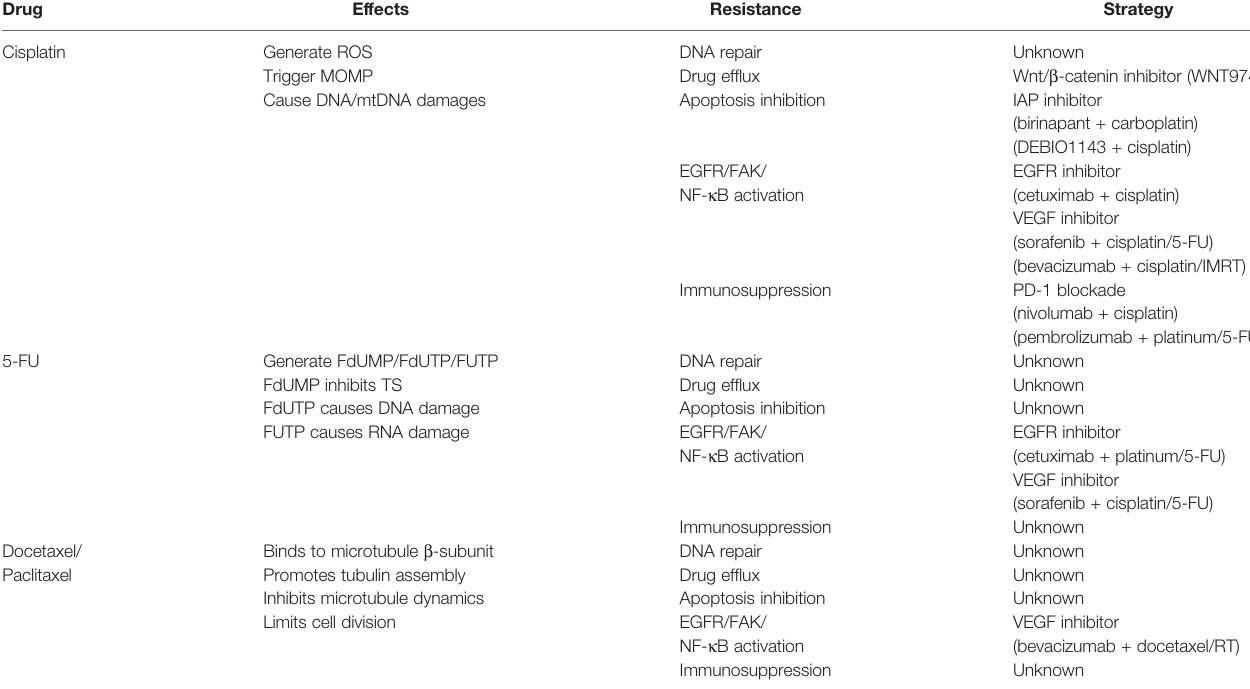
TABLE 2 | Summary of chemotherapy resistance in head and neck cancers (HNCs).